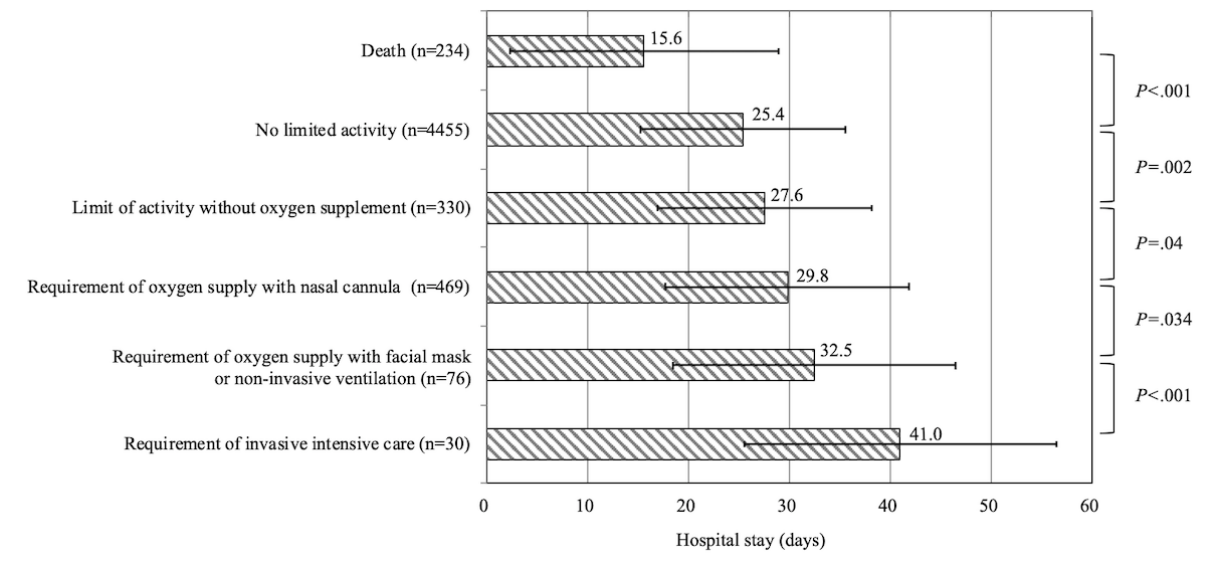
Figure 2. Maximal COVID-19 disease severity and duration of hospital stay. Hospital stay duration differed significantly according to maximal disease severity; the mean length of hospital stay is